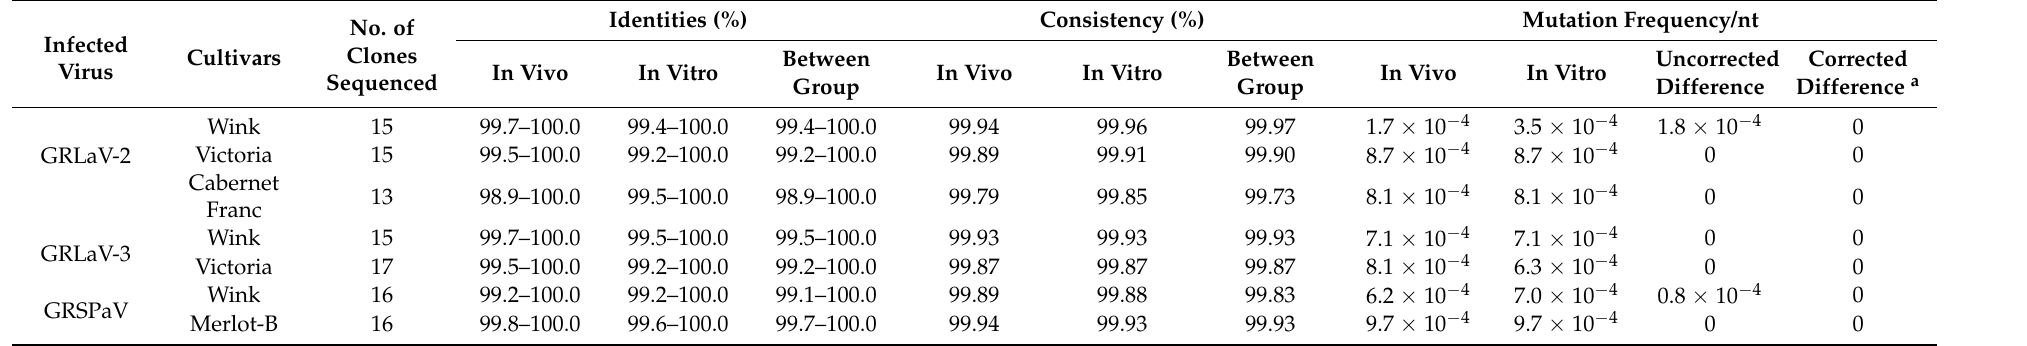
Infected Cultivars Virus